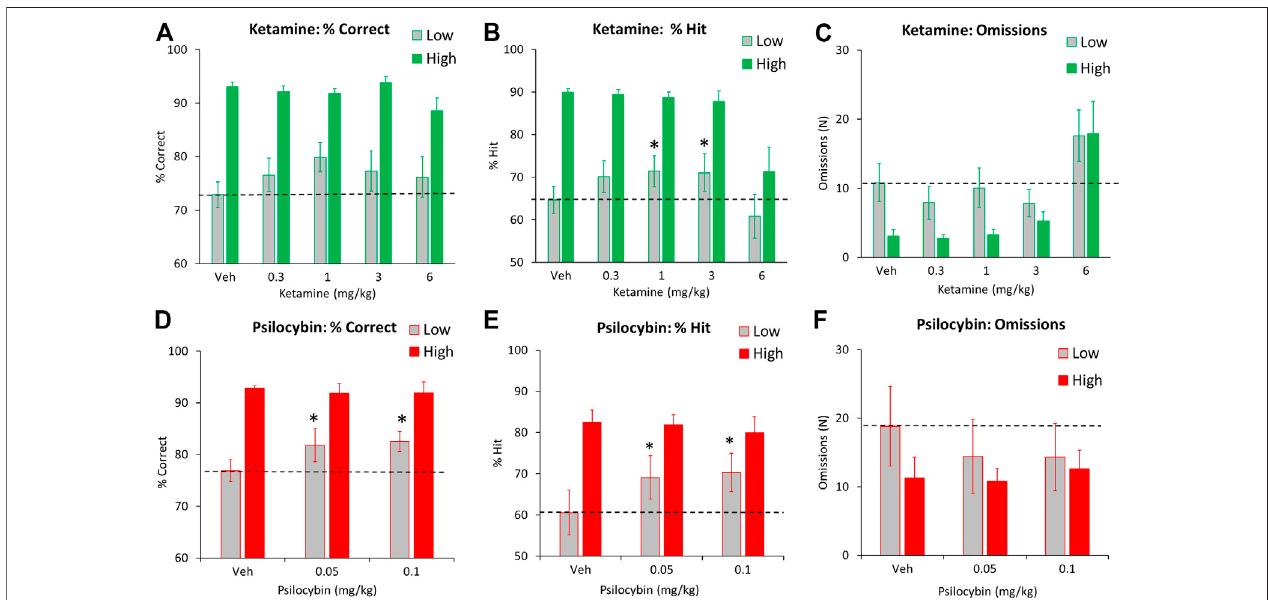
FIGURE 3 | Characterisation of ketamine (0.3 – 6 mg/kg IP) and psilocybin (0.05 – 0.1 mg/kg SC) on performance of rats in the 5-choice serial reaction time task. Test conditions of 0.75 s SD, 5 s ITI, 100 trials. Data is presented for both drugs as % correct, (A and D) , % hit (B and E) , and omissions (missed/incomplete) trials (C and F) . Data for each drug is presented for subjects characterized as “ high ” and “ low ” performers (ketamine: N (cid:1) 12 per tertile; psilocybin: N (cid:1) 8 per tertile), based on extreme tertile groups ranked on % correct performance measured over 7 days prior to onset of drug testing. The hashed line is to highlight the level of the “ low performer ” subgroup following vehicle pretreatment. * p < 0.05 vs. vehicle control (Dunnetts test following signi fi cant ANOVA).